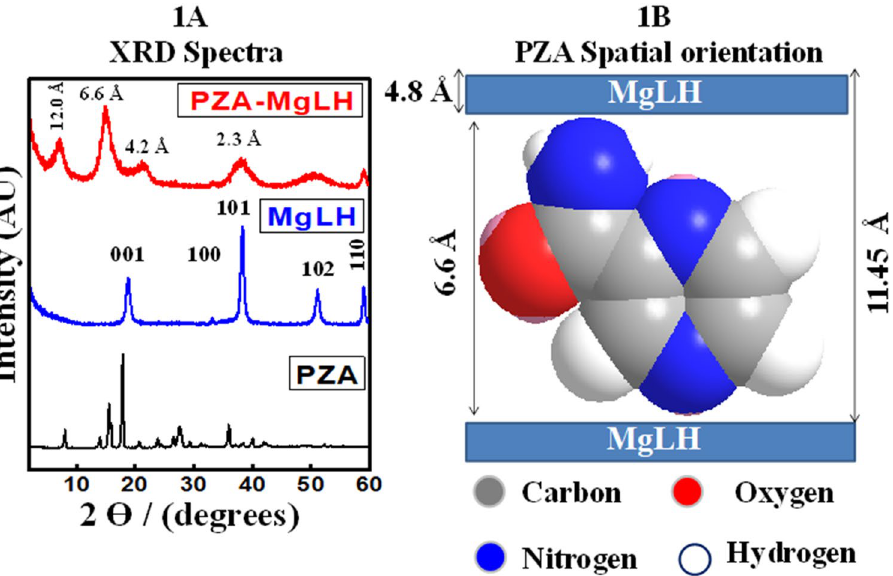
Figure 1. ( A ) XRD pattern of PZA, MgLH and PZA-MgLH nanocomposite and ( B ) the spatial orientation of PZA between the MgLH inorganic interlayers.